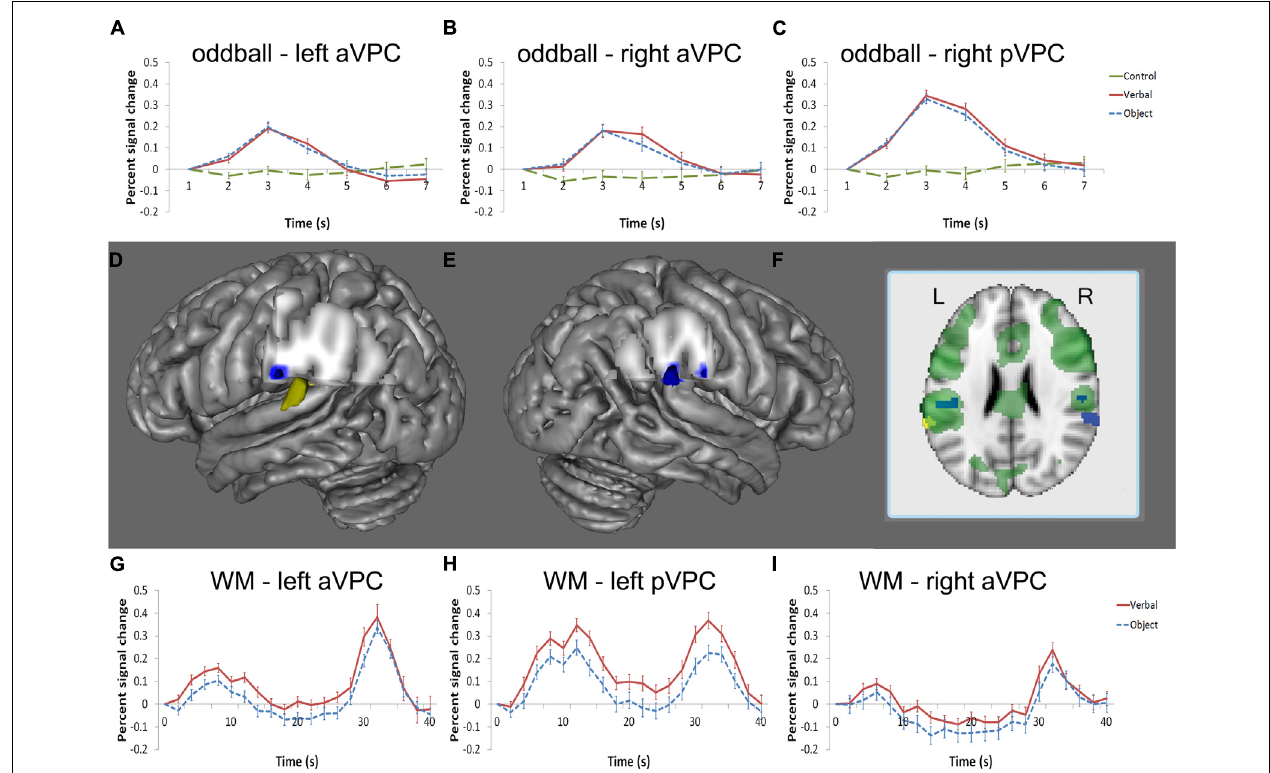
was active at encoding and retrieval (H) , but not for oddball detection whereas the homologous region in the right hemisphere (E) displayed the opposite pattern; namely, the right STG/VPC was reliably active in the oddball task (C) but not the WM task. The BOLD percent signal change is defined with respect to the image signal of the first time point of a trial, which is at the baseline. Note that only activity in regions of the STG and VPC is shown in the